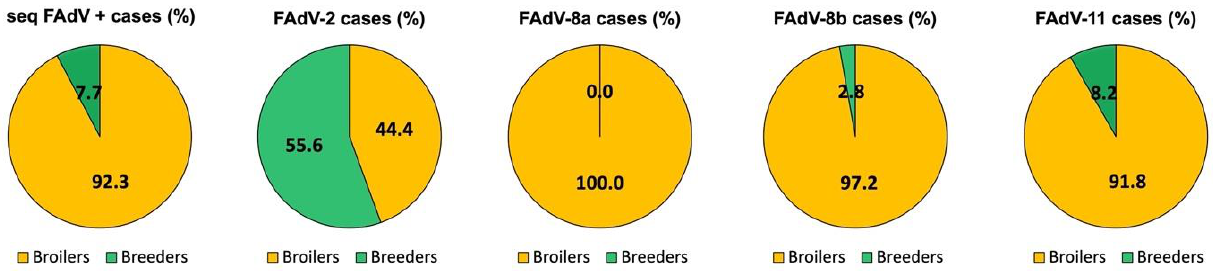
Figure 1. Distribution of sequenced FAdVs and FAdV serotypes by poultry type between 2011 and 2021 in Spain. Percentage of sequenced FAdV positive cases and FAdV serotypes in broilers (yellow) and broiler breeder pullets (green, referred to as Breeders).